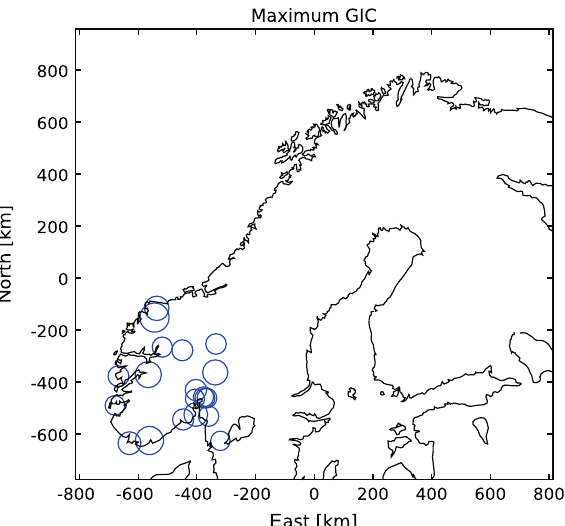
Fig. 7. Stations with the largest GIC in 1994–2011. The size of the circle is proportional to the amplitude of GIC. The maximum is about 400 A.